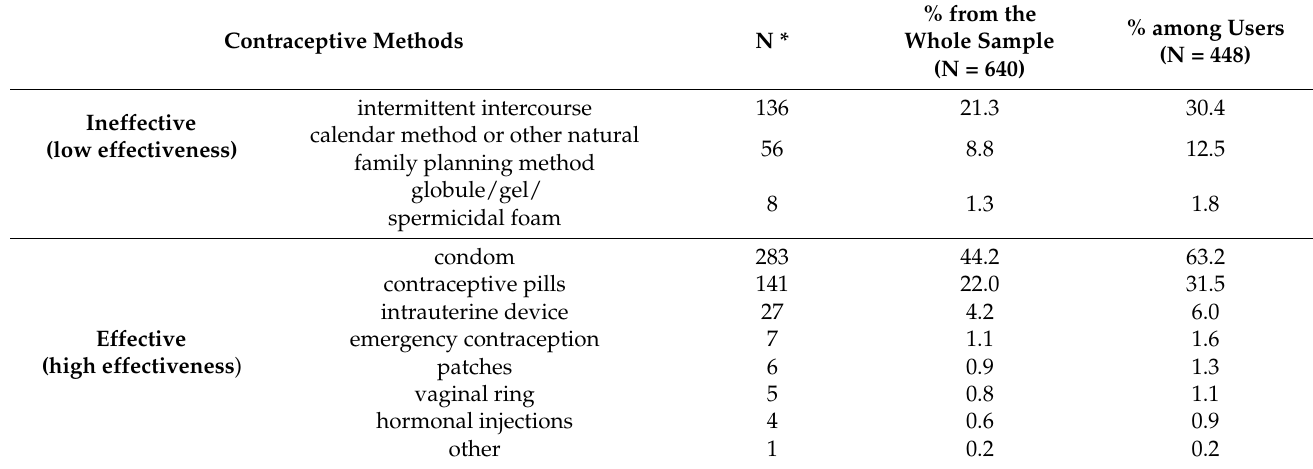
Table 2. The usage of contraceptive methods.